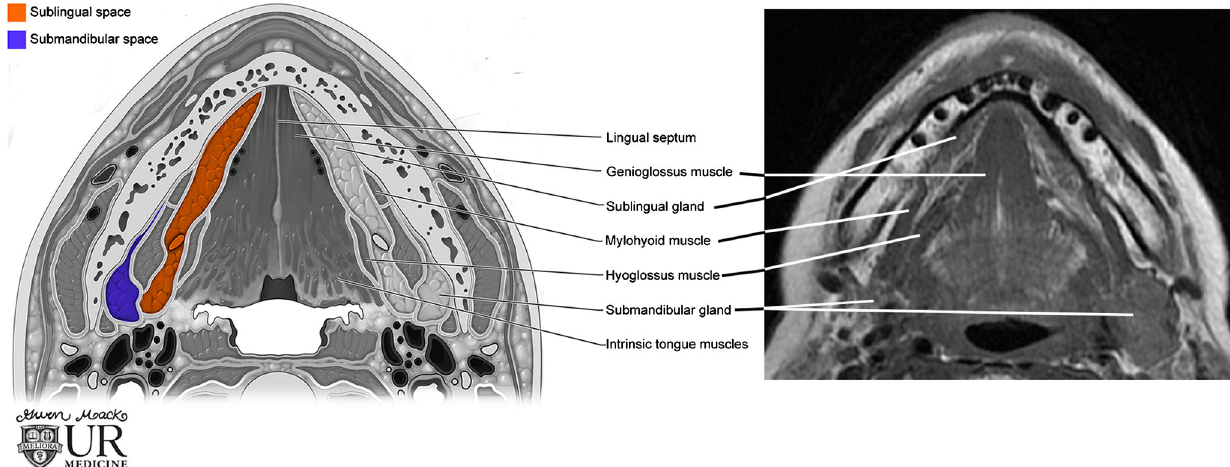
Fig. 1 Anatomy of the submandibular and sublingual spaces in the axial plane: picture illustration and T1-weighted MR